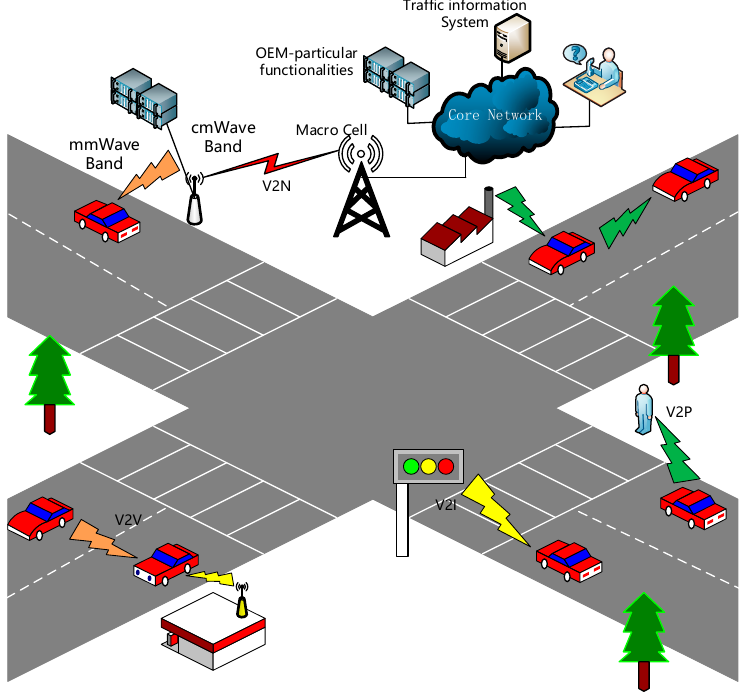
Figure 1. The scenario of